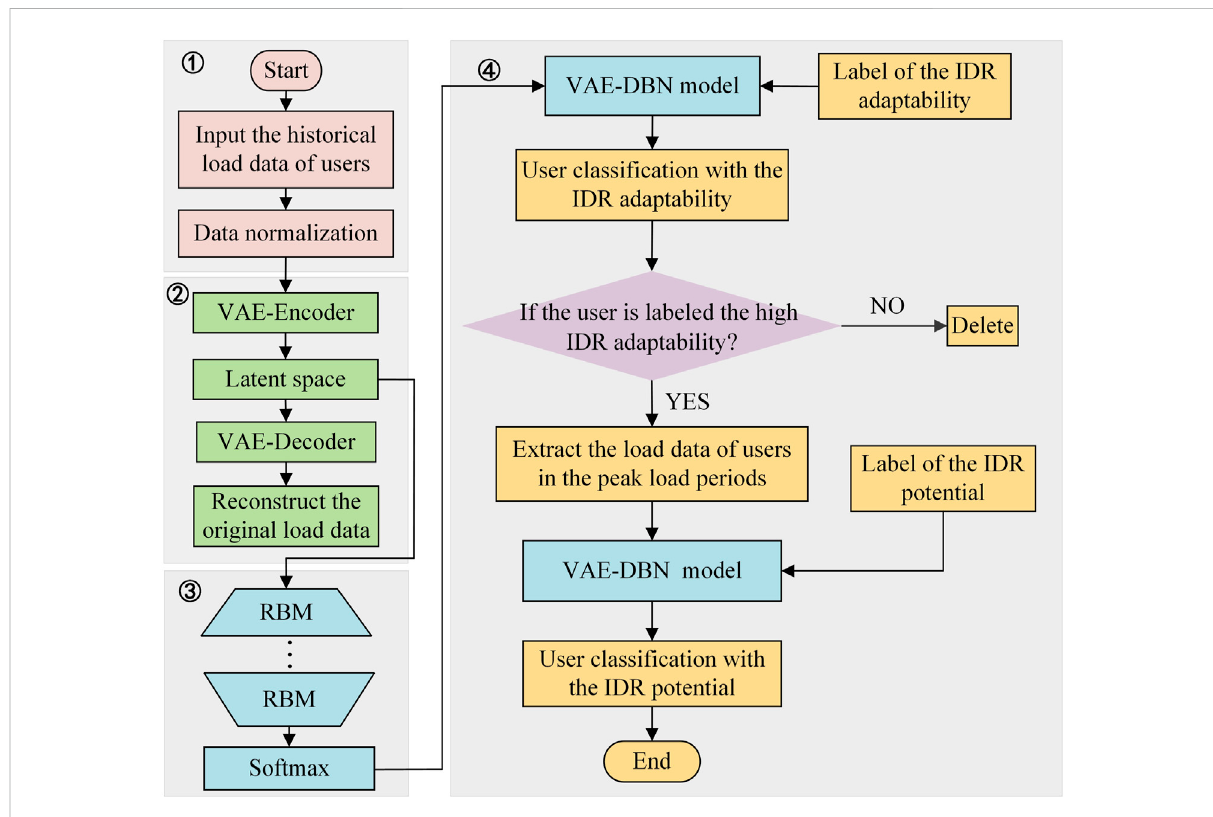
FIGURE 4 The detailed process of the VAE-DBN classi fi cation